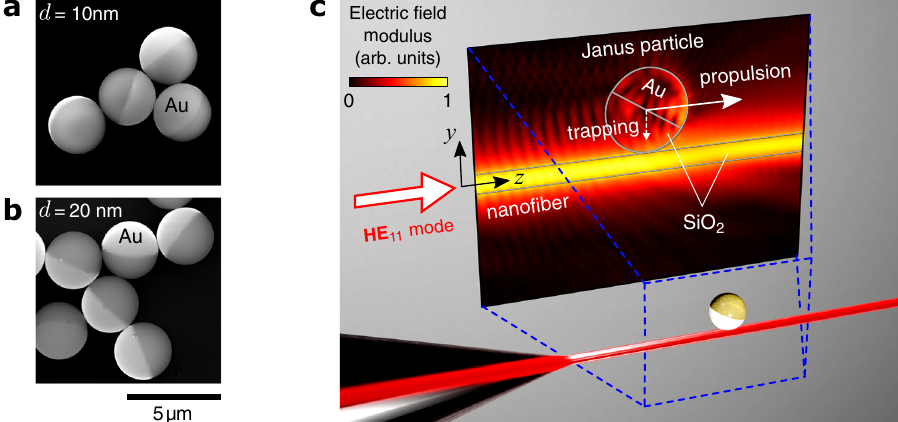
Fig. 1 | Janus particles and the nano fi ber-based manipulation concept. a, b Scanning electron microscope (SEM) images of silica-gold JPs used in this study ( d =10nmand20nmisthegoldcoatingthickness). c ArtisticviewofaJPincontact withthewaistregionofanONFguidingafundamentalmode, HE 11 ,polarizedinthe symmetry plane of the ONF-JP system ( yz -plane). The electric fi eld distribution